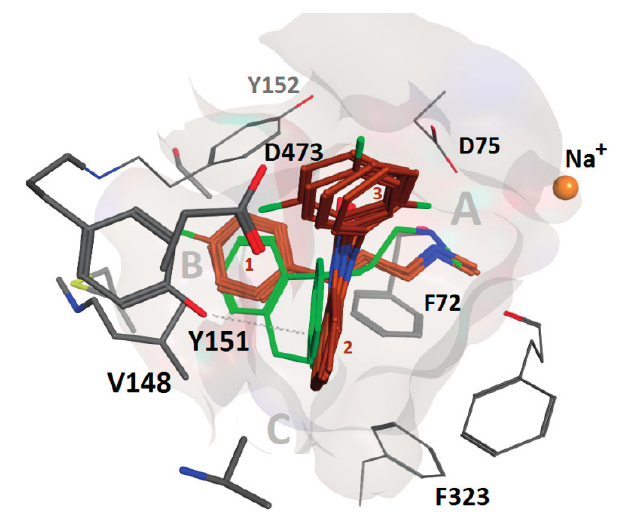
Figure 4. Overlay of compounds 1 , 2 , and 4 – 6 (maroon) in binding hypothesis 2 in hNET showing agreement with the co-crystal pose of nortriptyline ( 31 ) (green). Val148